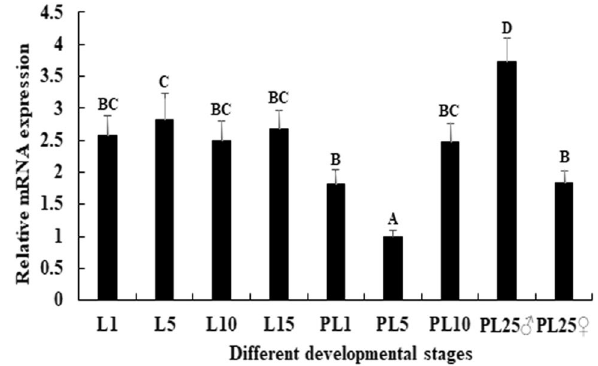
Figure 5. Expression characterization of Mn-HSDL1 in different developmental stages. The amount of Mn-HSDL1 mRNA was normalized to the EIF transcript level. Data are shown as mean ± SD (standard deviation) of tissues from three separate individuals . Capital letters indicate expression difference between different samples ( P < 0.05).